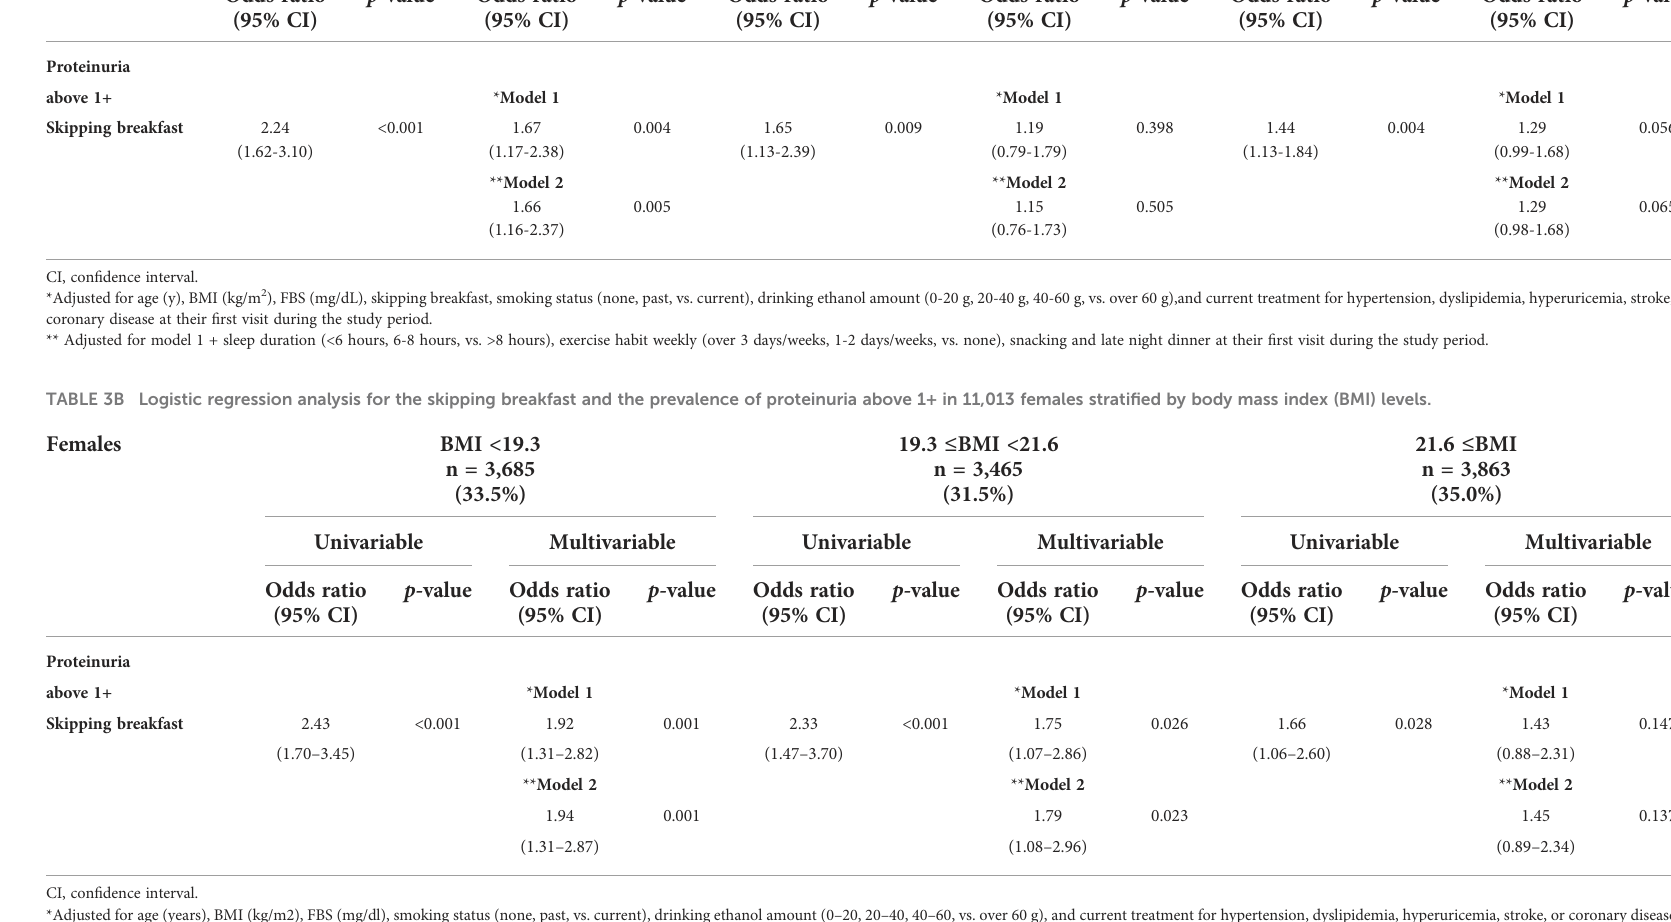
above 1+ Skipping breakfast